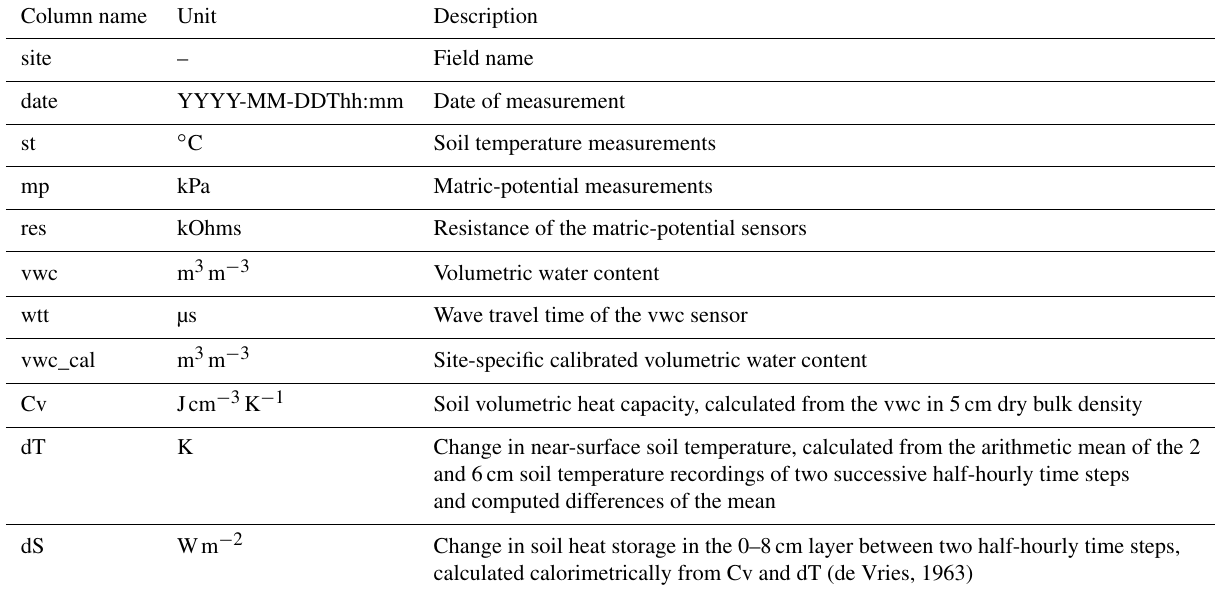
Table 13. Determined variables and description of the soil water content, temperature, heat storage and matric-potential measurements. Partially, the research sites had different numbers of sensors of a given type. All had temperature sensors installed at 2, 6, 15, 30 and 45cm soil depth, and matric-potential and volumetric water content sensors were installed at 5, 15, 30, 45 and 75cm depth, which are given separately in the individual files. For this reason, each data file (soil_site ∗ _data.csv) has its own metadata file. ∗ denotes the site number and only is only reported for research sites EC1 to